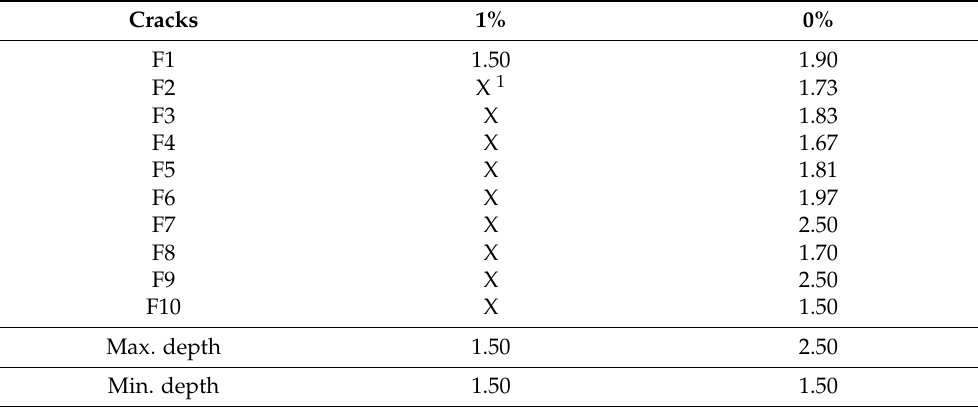
Table 6. Crack depth measured by ultrasound equipment (units: cm).